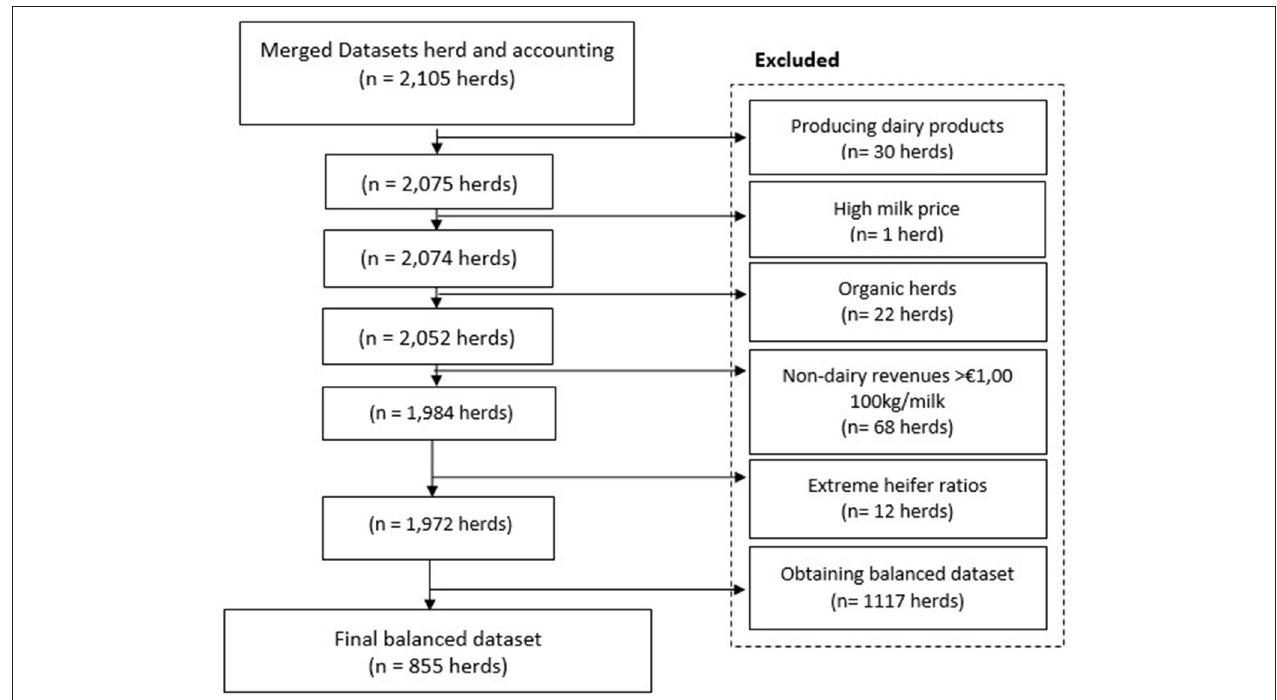
FIGURE 1 | Data editing steps, starting with the merged dataset till the final dataset containing 855